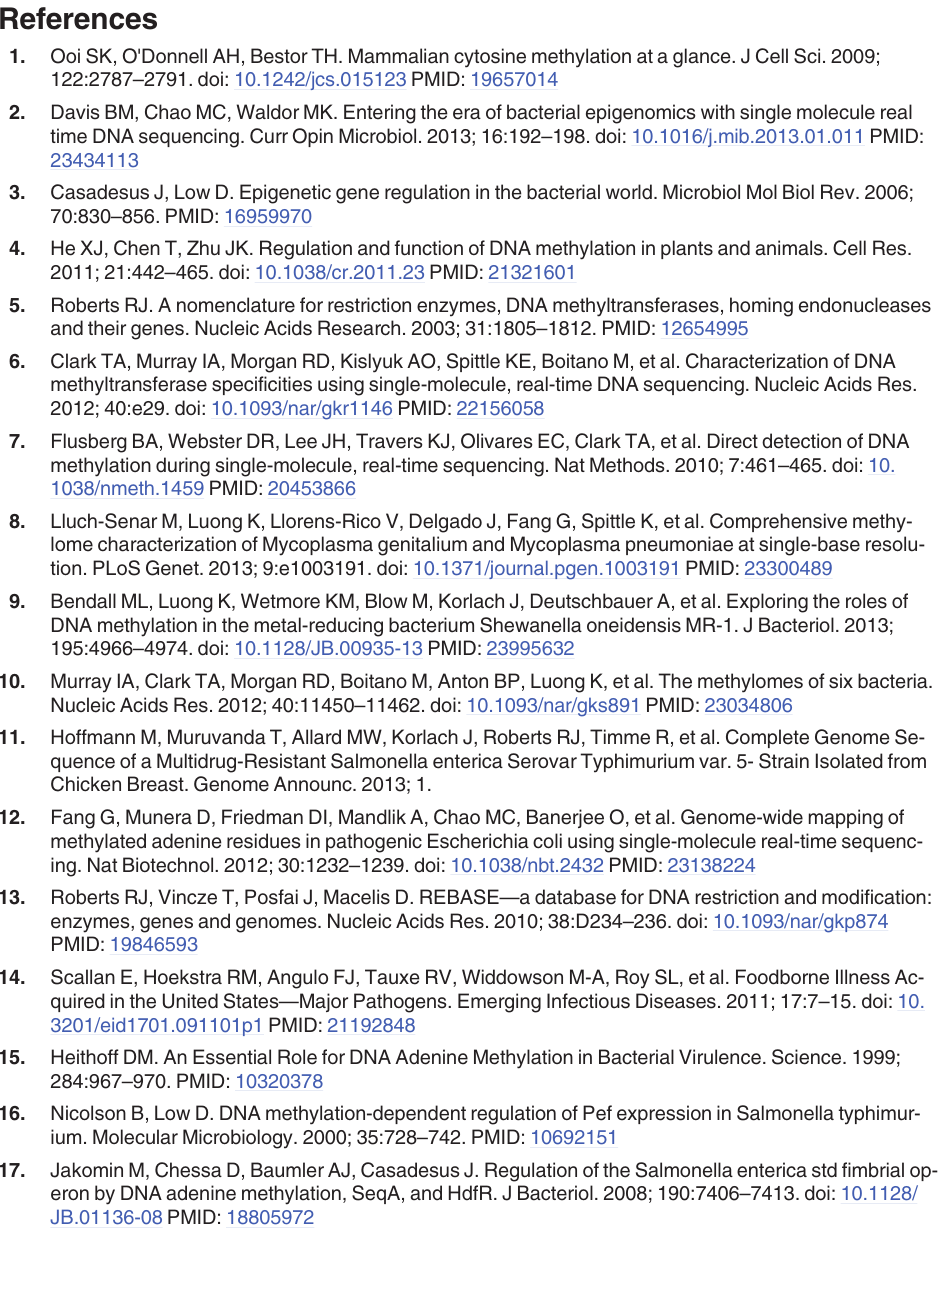
S1 Table. Explanation of MTase assignments. S2 Table. SRA Accession